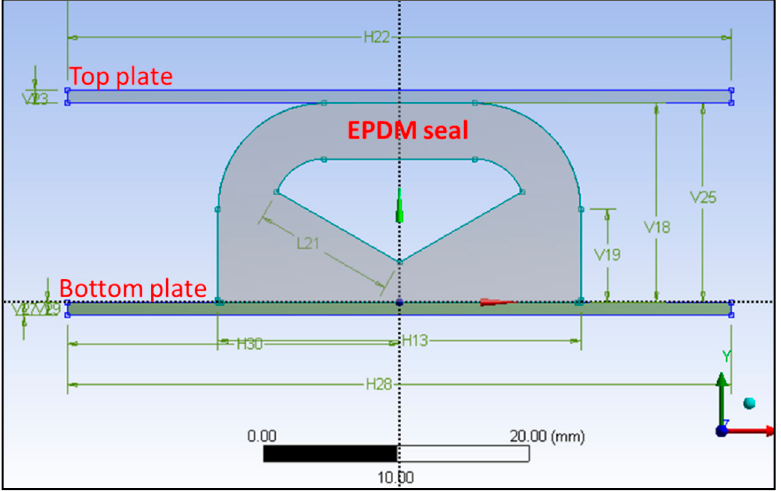
Figure 7. Geometry of the gasket seal before compression (Stage 1: Compression, Stage 2: Water Pressure).